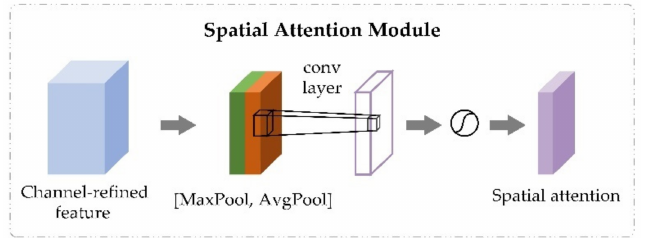
Figure 3. The spatial attention module in convolutional block attention